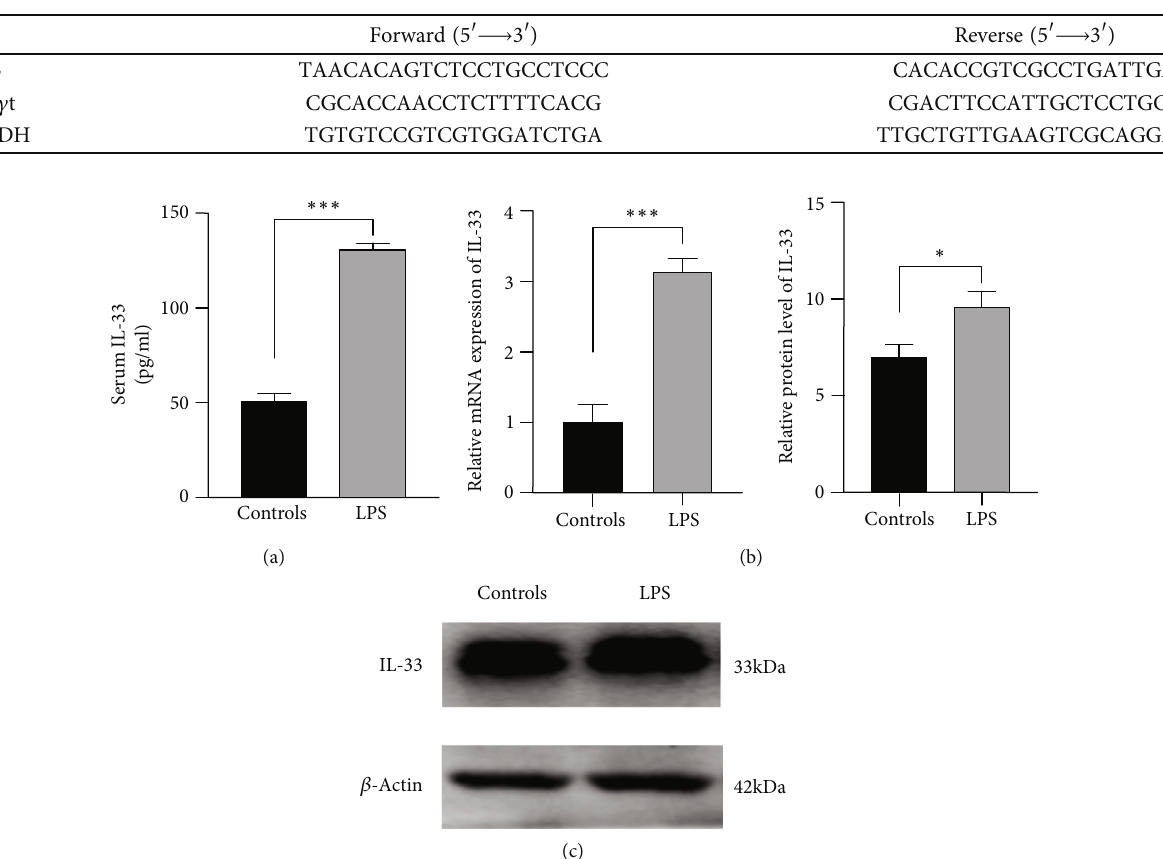
Figure 1: Elevated expression of IL-33 in mice with ARDS. (a) The protein level of IL-33 in peripheral blood was measured by ELISA. (b) The mRNA expression of IL-33 in the lung was measured by qRT-PCR. (c) The level of IL-33 protein in lung tissue was measured by Western blotting. The data are expressed as the means ± SDs . Signi fi cant di ff erences are shown by ∗ P < 0 : 05 , ∗∗ P < 0 : 01 , and ∗∗∗ P < 0 : 001 by unpaired Student ’ s t -tests comparing the normal WT controls and ARDS groups. N = 5 for each group, and three independent repeated experiments were carried